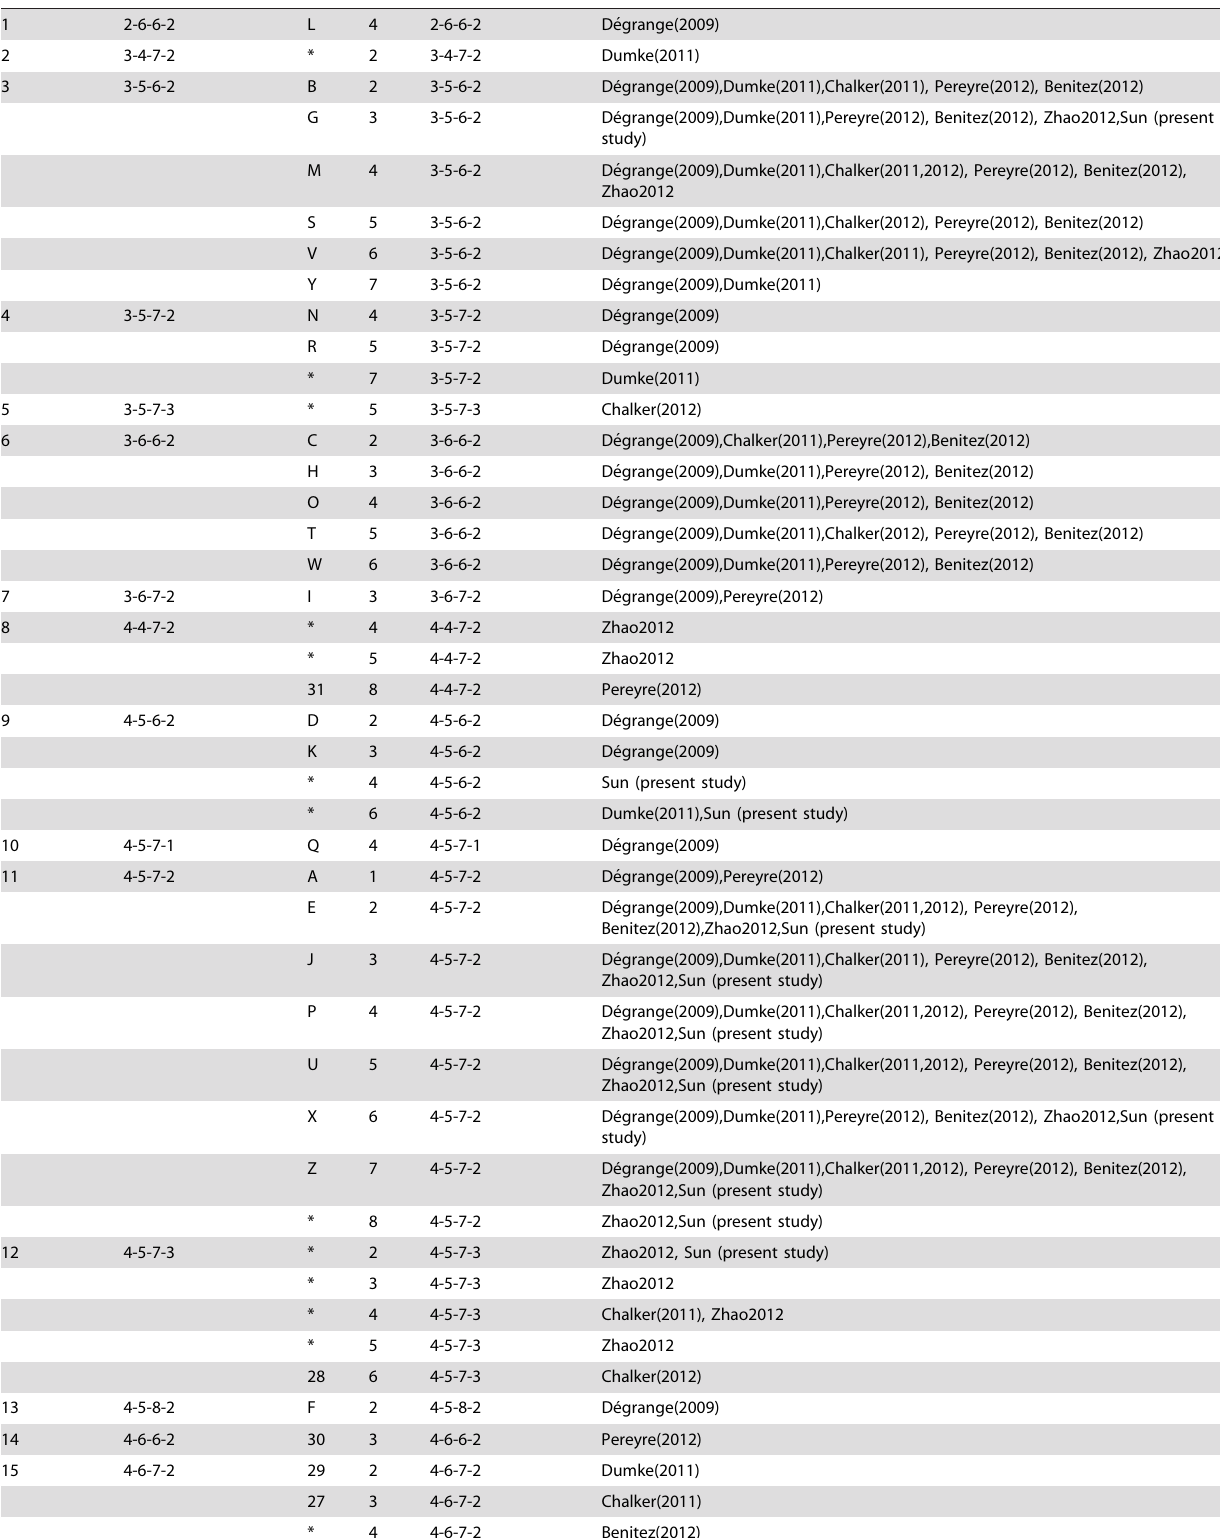
No. Of type 4-locus MLVA type MLVA Mpn1 Mpn13-14-